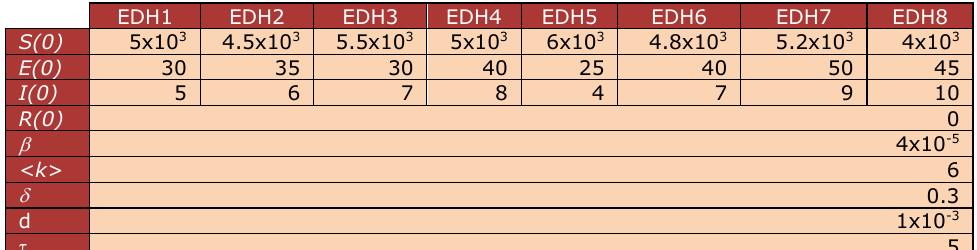
Table 1. Values of parameters in SEIR epidemic diffusion model